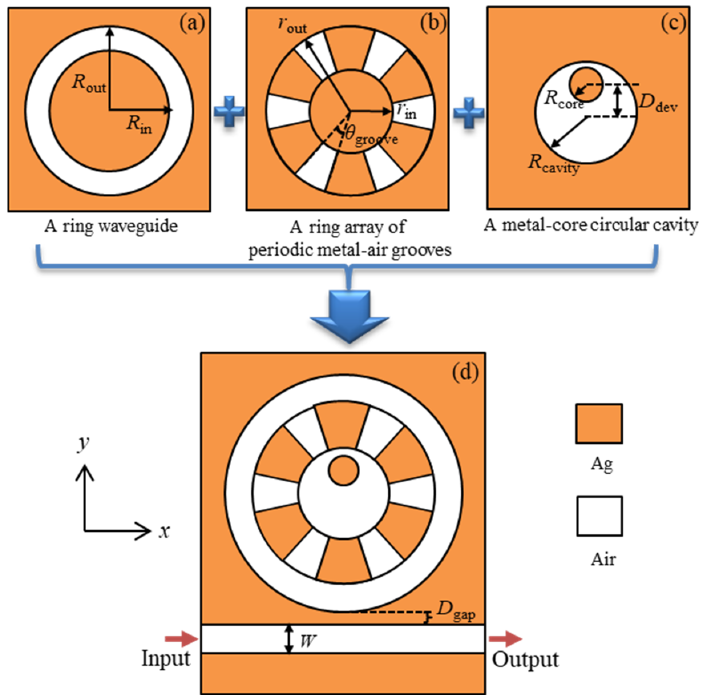
Figure 1. The cross-section schematic diagrams of plasmonic nanostructures; ( a ) a ring waveguide, ( b ) a ring array of periodic metal-air grooves, ( c ) a metal-core circular cavity, and ( d ) a fan-shaped cavity formed by the three basic elements above and a side-coupled straight